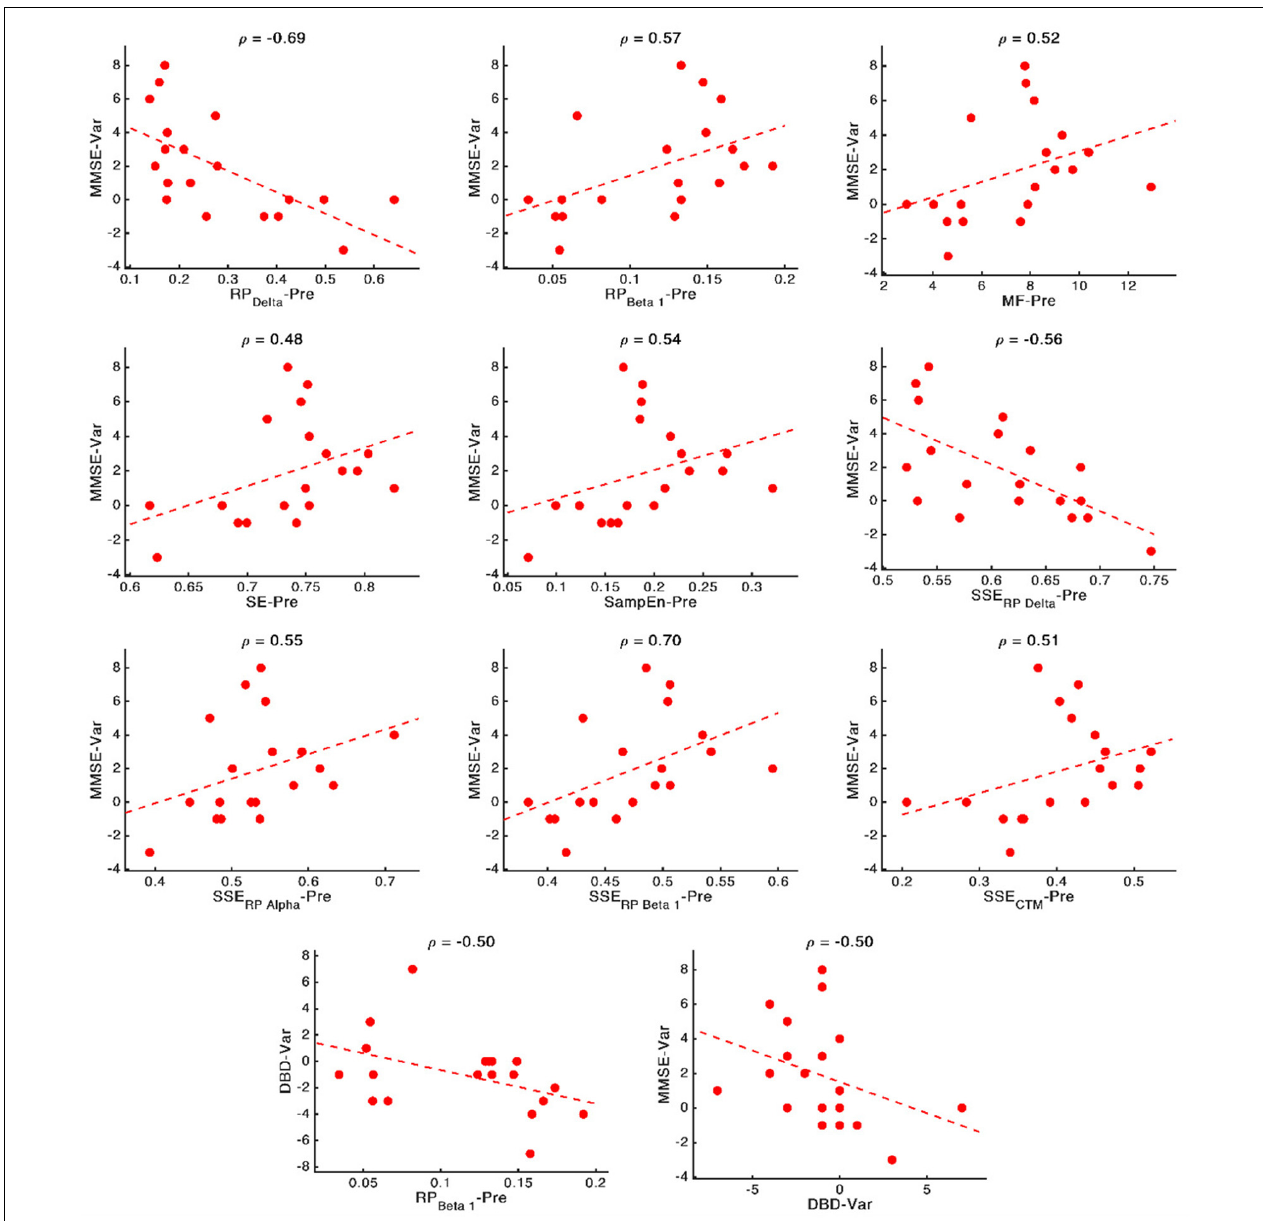
FIGURE 7 | Scatterplots representing the relationship between the neurophysiological parameters computed before applying the NPT (x-axis) and the changes in cognitive and behavioral variables after the NPT (y-axis). In the top part of each panel, the value of the Spearman rank correlation for each specific pair of parameters is plotted. Dashed lines represent the linear regression of the